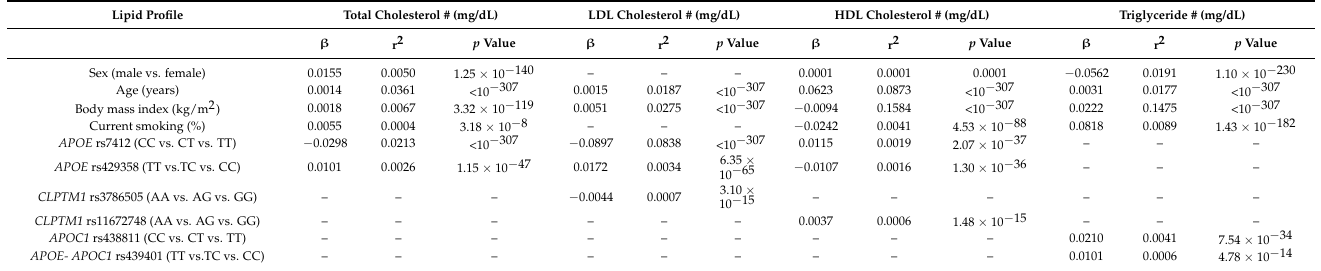
Table 3. Stepwise linear regression analysis including APOE region polymorphisms.